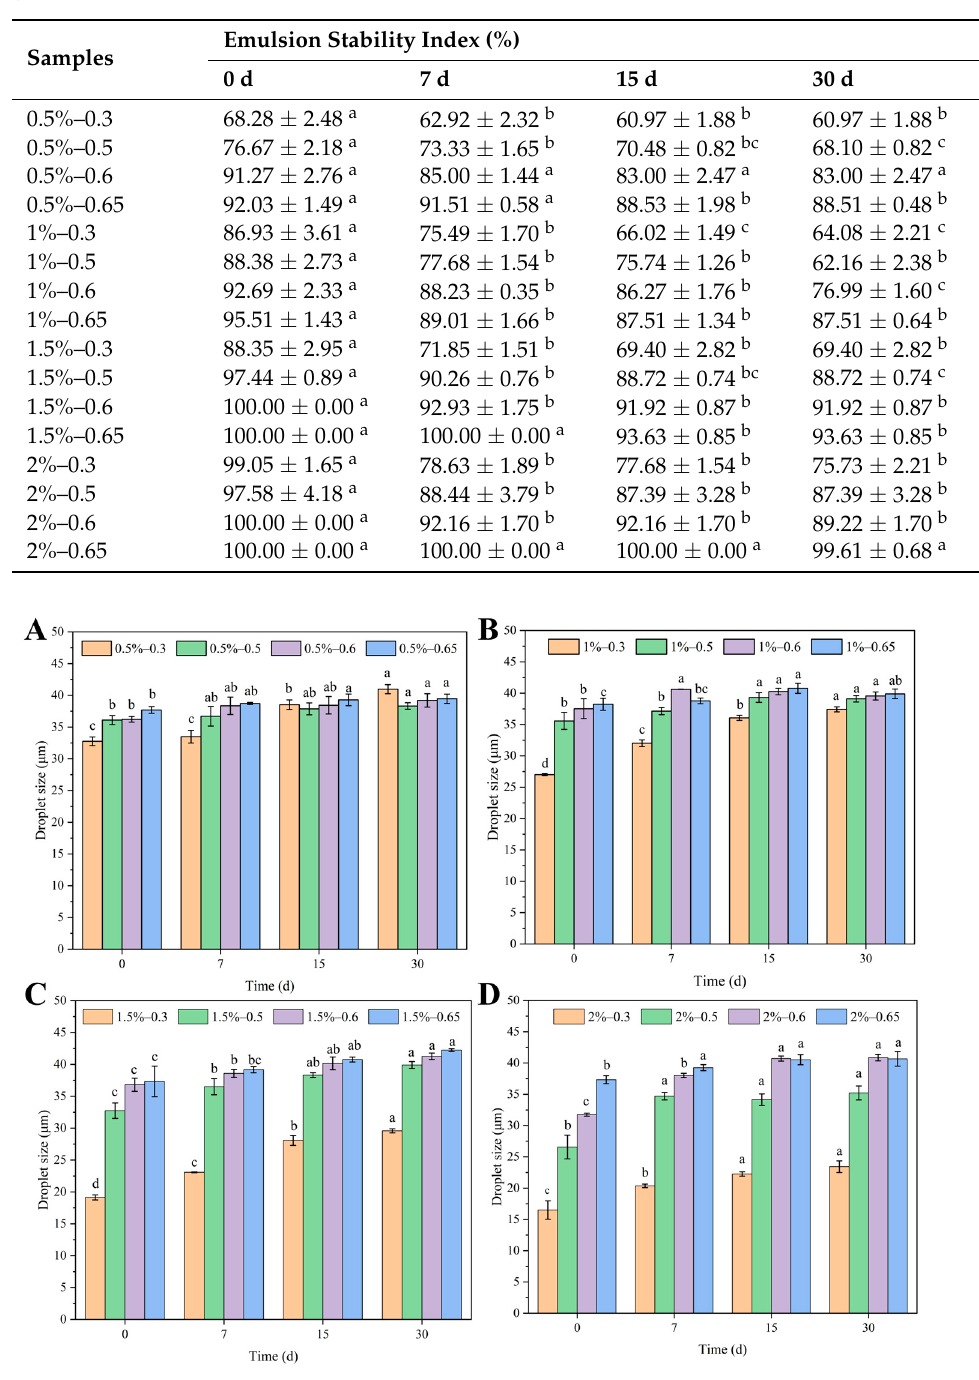
Figure 5. Droplet size of Pickering emulsions stabilized with different c (0.5–2 wt%) of LF–FD complexes at different φ (0.3–0.65): ( A ) c = 0.5 wt%; ( B ) c = 1 wt%; ( C ) c = 1.5 wt%; ( D ) c = 2 wt%. The different letters represent significant differences ( p < 0.05).